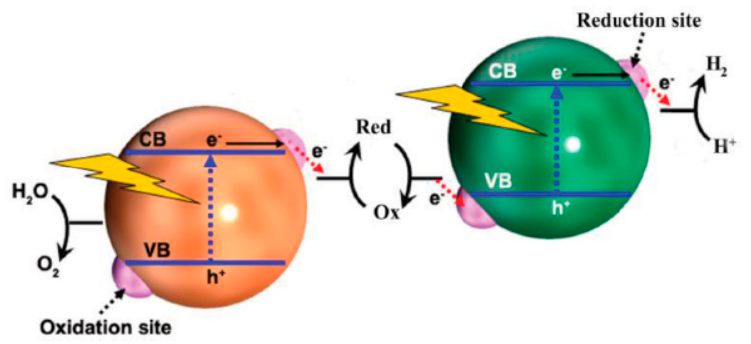
Figure 3. Schematic illustration of the Z-scheme